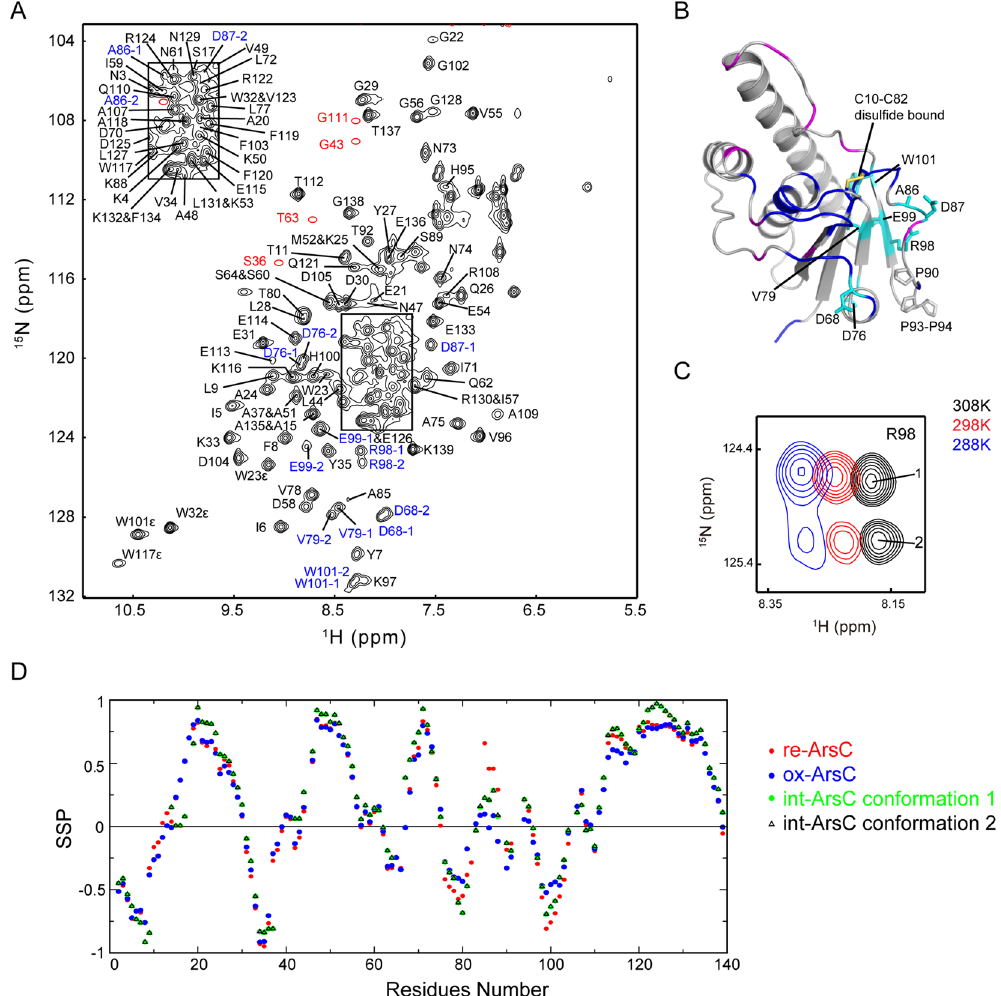
Figure 3. Assignments and structural characterization of int-ArsC . ( A ) The 1 H- 15 N HSQC spectrum of int- ArsC labeled with backbone resonance assignments. The positions of the weak resonances are indicated by red circles in the spectrum. Residues showing two sets of peaks are labeled in blue with ‘ − 1’ and ‘ − 2’ designating two conformations. ( B ) Mapping of residues with backbone amide resonances missing (blue) or significantly broadened (magenta), and residues with two sets of backbone amide resonances (shown as cyan sticks) onto the structure model of int-ArsC . The C10–C82 disulfide bond and the three proline residues in this region are also shown. ( C ) Representative local spectral region showing the two sets of signals from R98 at different temperatures. ( D ) Secondary structure propensity derived from the chemical shifts from 15 N, 13 C α , 13 C β , 13 CO, 1 H α and 1 H N atoms using the program package SSP 30 for re-ArsC , ox-ArsC and int-ArsC with the two sets of conformations. SSP values close to 1 indicate high propensity of α -helices, whereas SSP values close to − 1 indicate high propensity of β